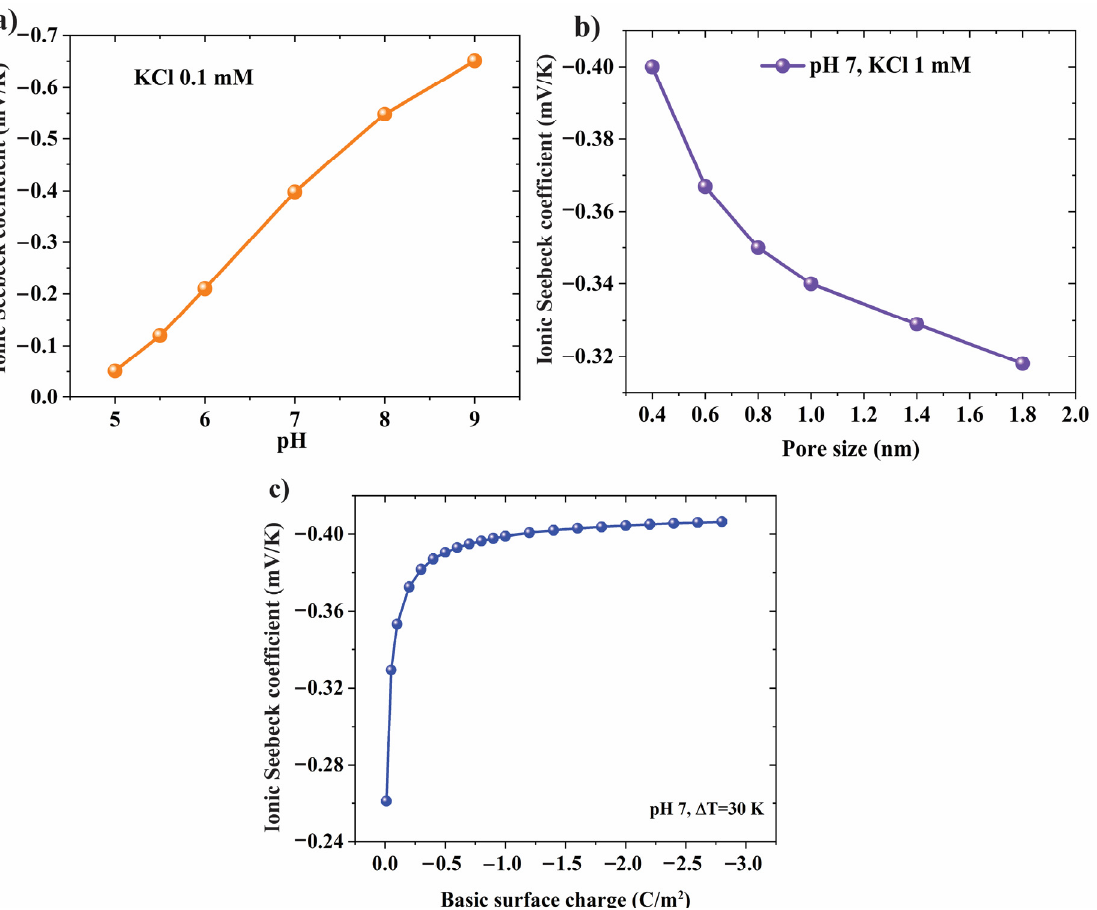
Figure 5. ( a ) Ionic Seebeck coefficient as functions of pH level, ( b ) pore size, and ( c ) basic surface